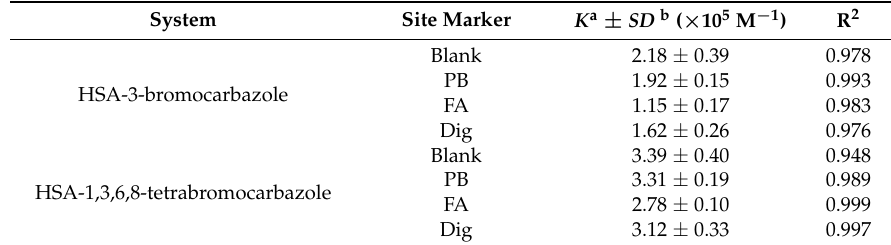
Table 3. Effects of the site probes on the binding constants of 3-bromocarbazole and 1,3,6,8- tetrabromocarbazole to